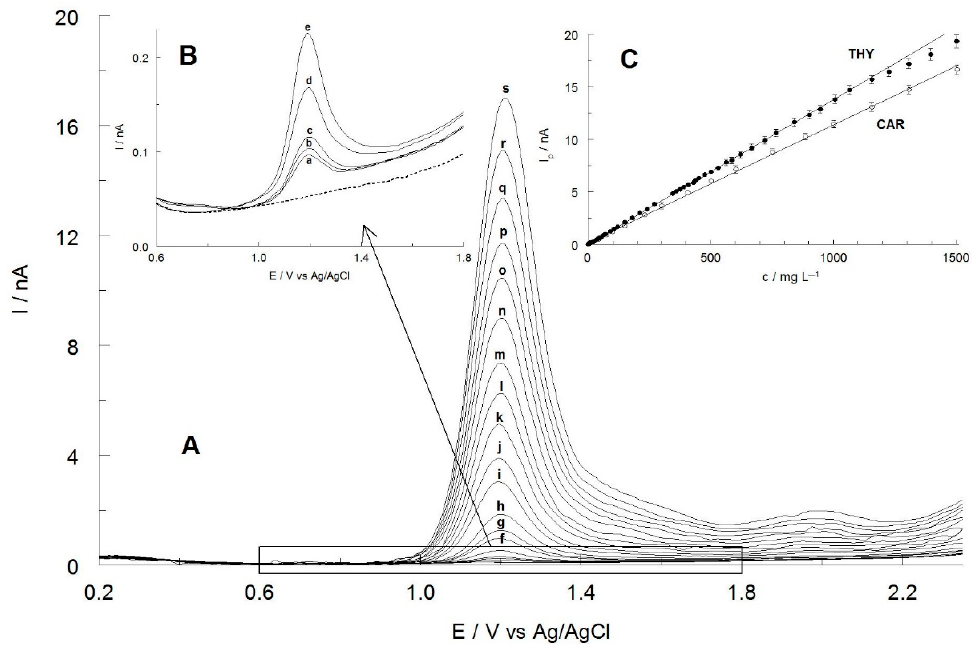
Figure 4. ( A ) DPV curves recorded in solutions containing different concentrations of CAR ranging from (a) 0.5 to (s) 1504 µg mL − 1 . ( B ) Enlarging part of the picture A. ( C ) Calibration plots for THY and CAR.